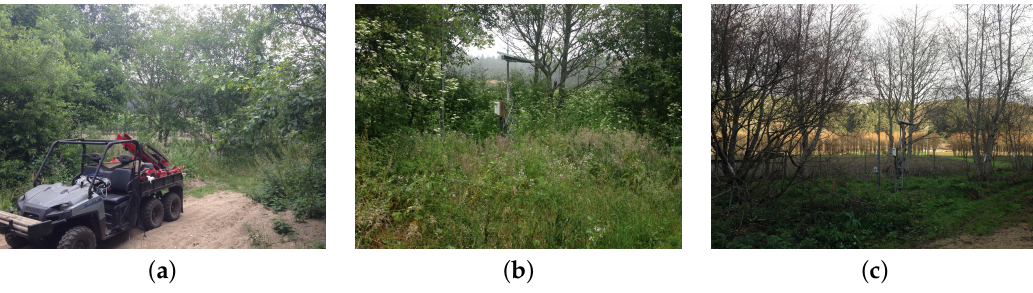
Figure 2. Typical vegetation, including ( a ) phreatophytic trees ( b ) understory vegetation, and ( c ) de- ciduous vegetation during winter dormancy in the study area within the lower Scotts Creek riparian corridor in June 2017, June 2018, and January 2019, respectively.